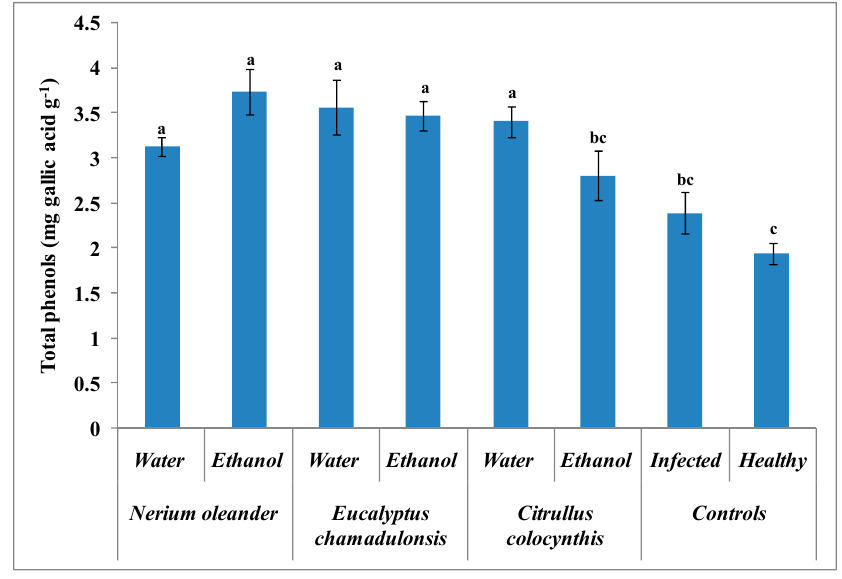
Figure 2. Effect of 15% concentrations of plant extracts of Nerium oleander, Eucalyptus chamadulonsis and Citrullus colocynthis on total phenols of ‘Super Marmande’ tomato after 7 days of treatment with the extracts and inoculated with Xanthomonas axonopodis pv. vesicatoria PHYXV3. Four replicates were used for each treatment. Columns with the same letters are not significantly different according to Fisher’s protected least significant difference at p ≤ 0.05.